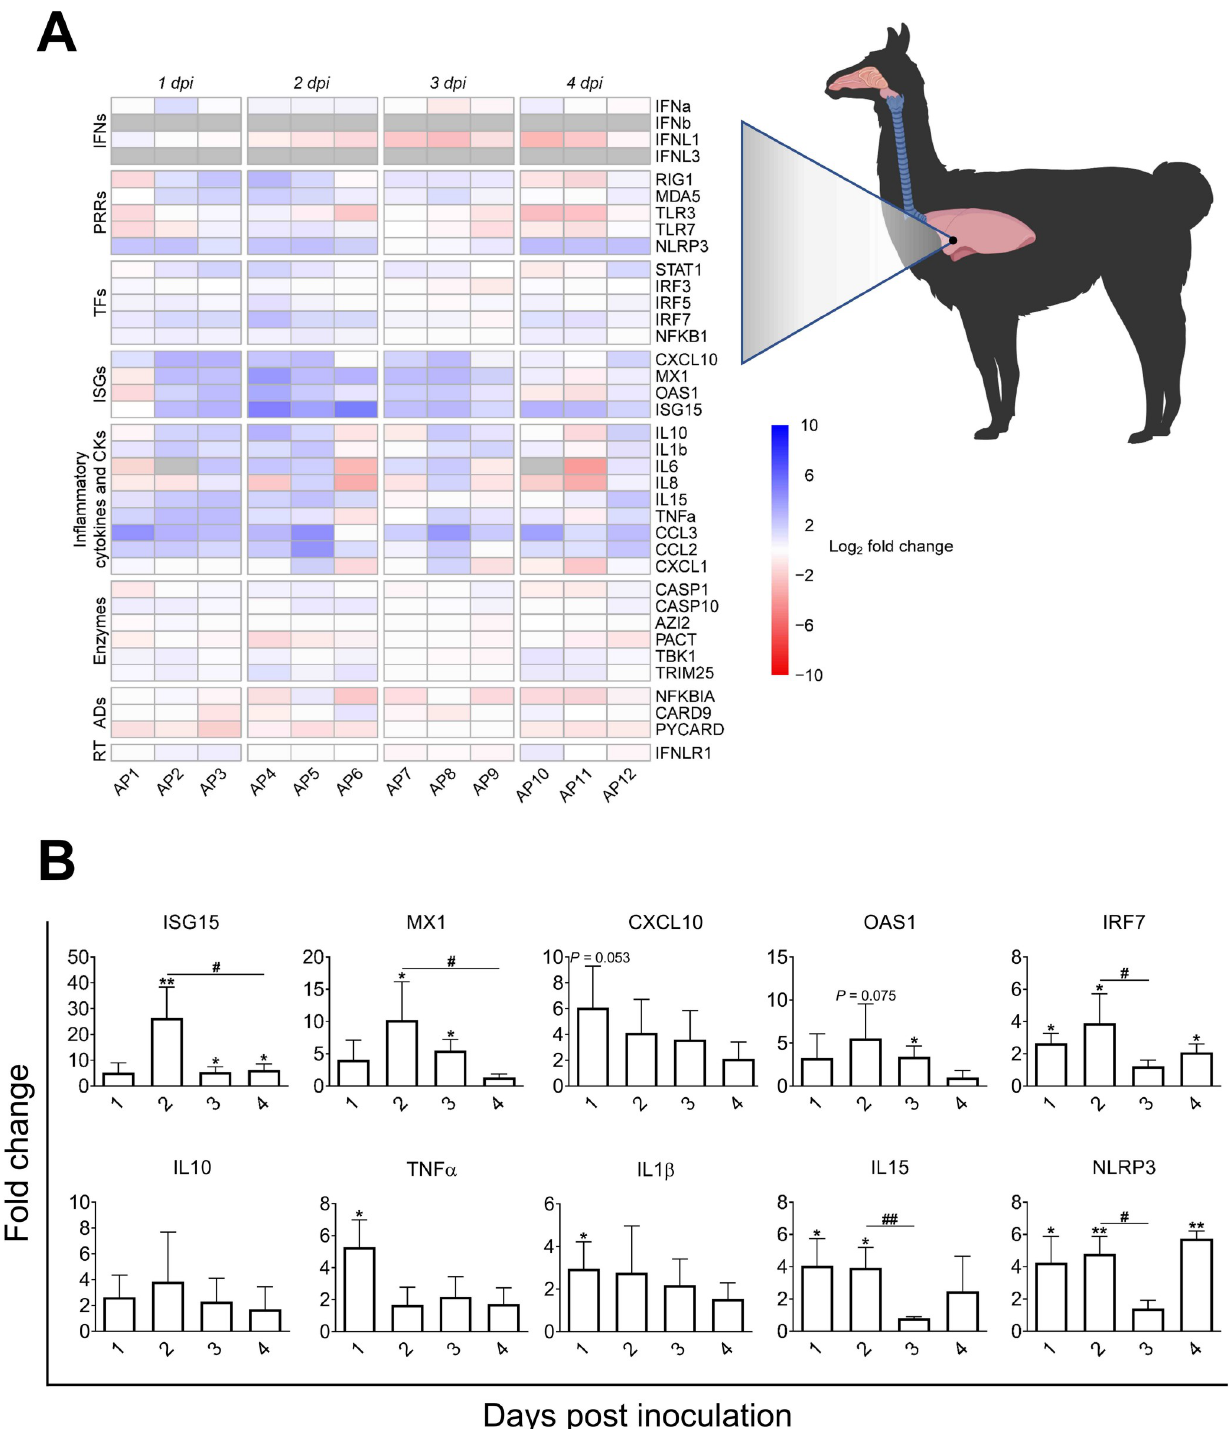
Fig 6. Kinetics of alpaca innate immune responses in the lungs following MERS-CoV Qatar15/2015 infection. (A) The lung sample of each infected alpaca (AP1 to AP15) was isolated for RNA extraction and conversion to cDNA. A Fluidigm Biomark microfluidic assay was used to quantify transcripts of innate immune genes at different dpi. After normalization, Fc values between controls and infected animals were calculated. The resulting heatmap shows color variations corresponding to log2 Fc values; blue for increased and red for decreased gene expression, respectively. The grey rectangles indicate no expression of the corresponding gene. TFs, transcription factors; CKs, chemokines; ADs, adaptors; RT, receptor. (B) Bar graphs representing average mRNA fold changes of ISGs (ISG15, MX1, CXCL10 and OAS1), IRF7, NLRP3, the inflammatory cytokines IL1 β , TNF α , IL10 and IL15 genes in lung. Data